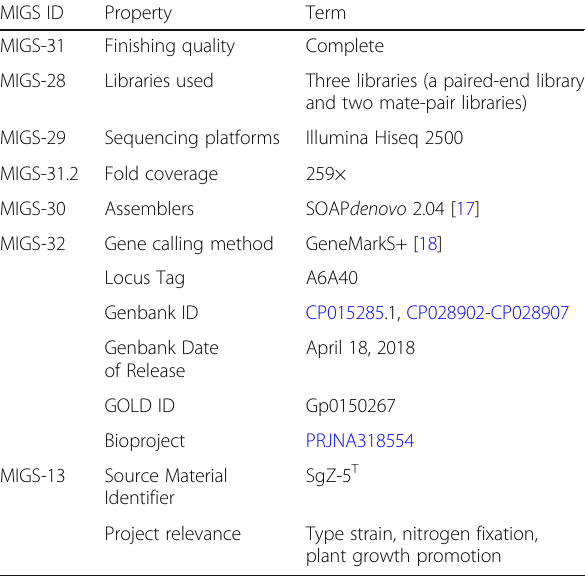
Table 2 Genome sequencing project